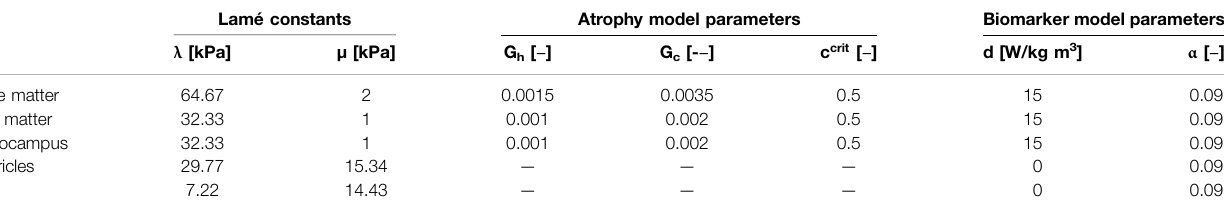
TABLE 1 | Multiphysics atrophy model parameters which include Lamé constants, healthy and pathological atrophy rates, critical biomarker concentration, and biomarker spreading parameters for white matter, gray matter, the hippocampus, ventricles, and cerebrospinal fl uid. Lamé constants Atrophy model parameters Biomarker model